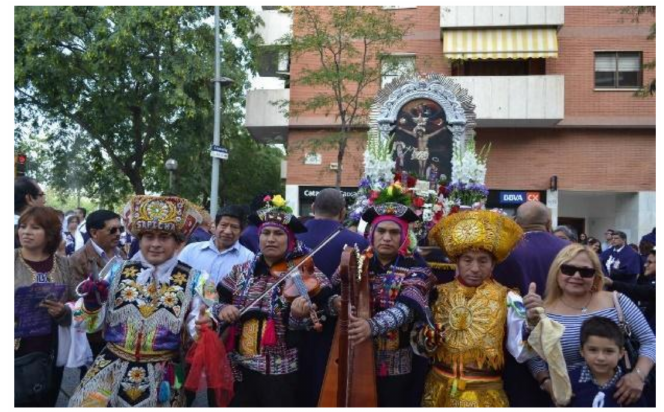
Figure 5. Dancers and musicians of the scissors dance. R ó mulo Lliuyacc is dressed in yellow, October